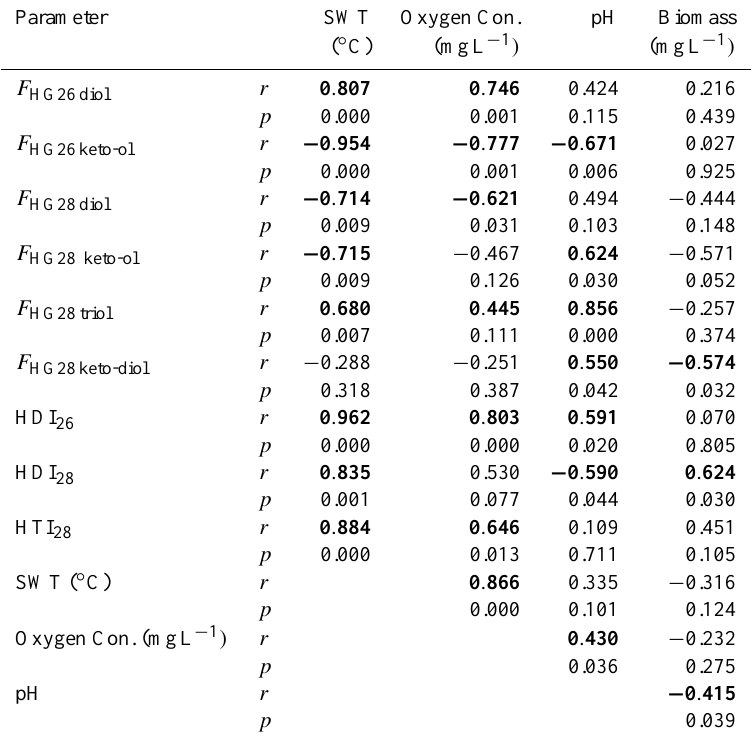
Table 1. Correlations of fractional abundances ( F ) of individual heterocyst glycolipids and heterocyst glycolipid indices with SWT, oxygen concentration, pH and biomass. Significant correlations were observed, among others, between fractional abundances of heterocyst gly- colipids and SWT as well as between the different HG indices and SWT. Note that certain environmental parameters were also positively correlated with each other. Significant correlations are indicated in bold. r = correlation coefficient; p = p value.